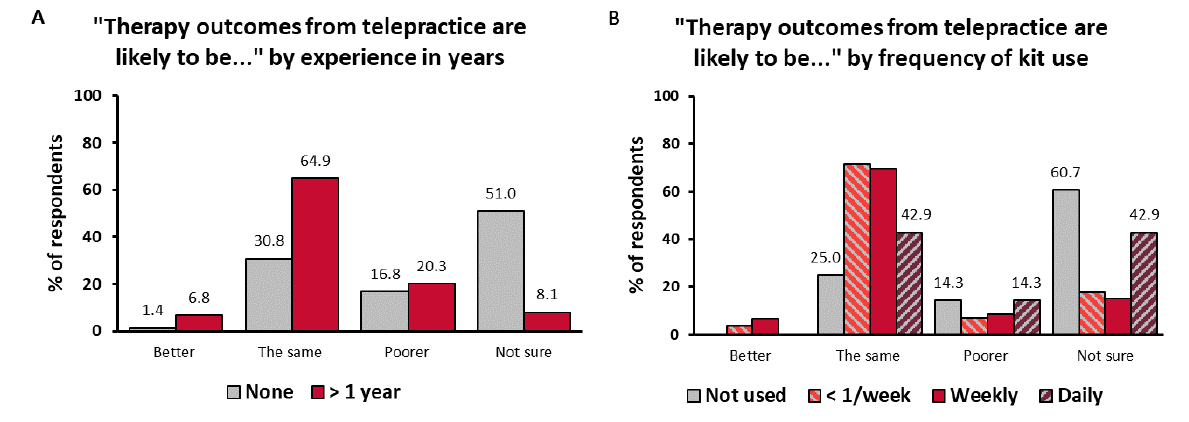
Note. Figure 4.A: Telepractice outcome expectations according to clinician’s experience in telepractice (gray: no experience, n = 143; red: more than 1 year of experience, n = 74); Figure 4.B: Telepractice outcome expectations according to the frequency of the MED-EL Remote Lesson Kit use, (gray: not used, n = 28; light red, striped: less than once per week, n = 28; red: weekly, n = 46; dark red, striped: daily, n = 7).